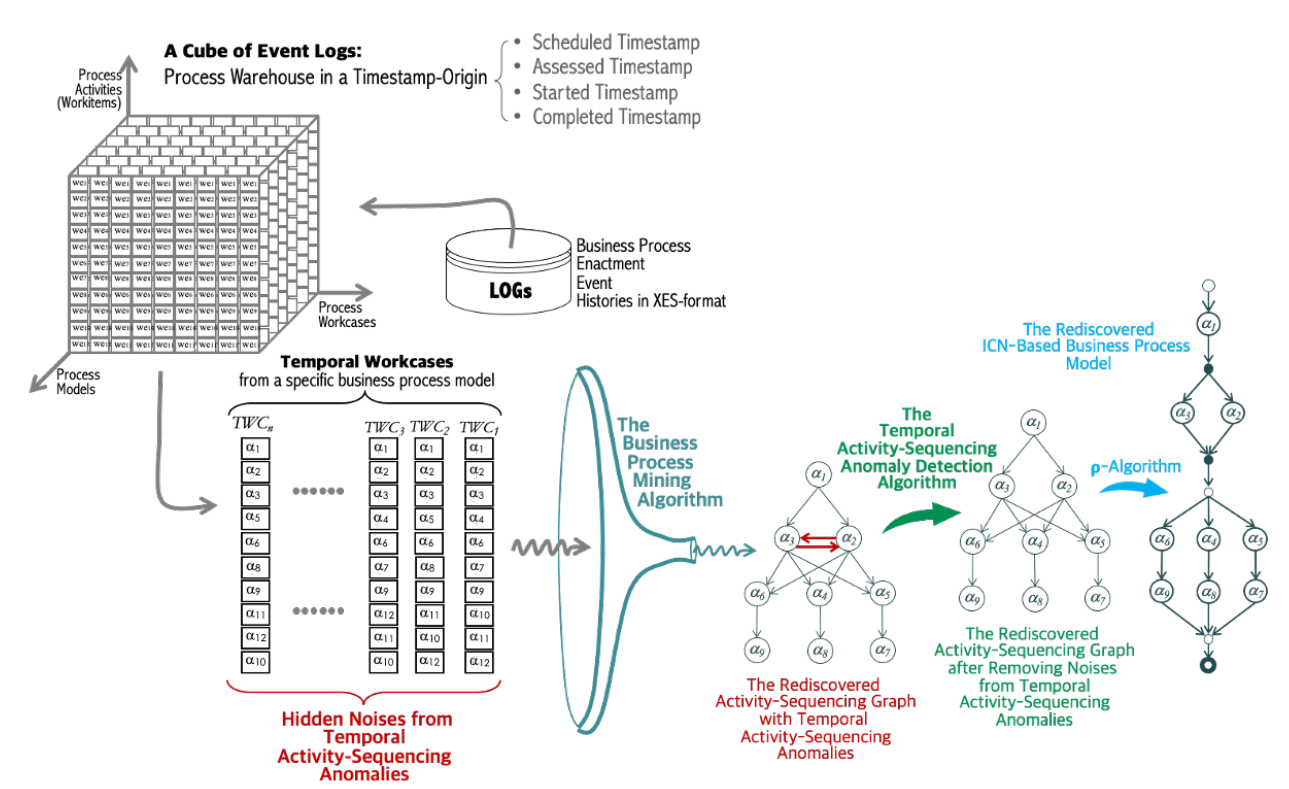
Figure 1. Activity-sequencing graph in the process-mining framework addressing temporal activity- sequencing